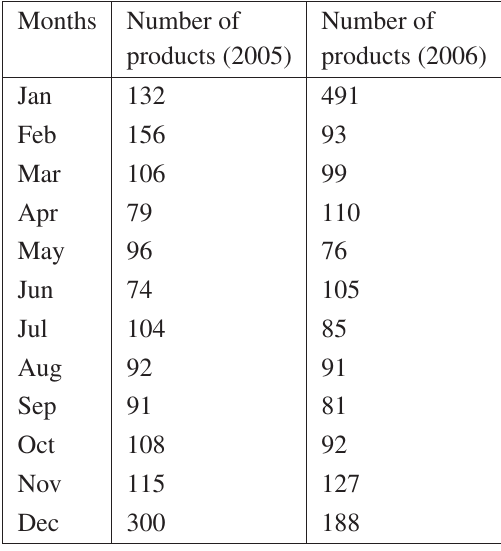
Table 6. The distribution of single month selling